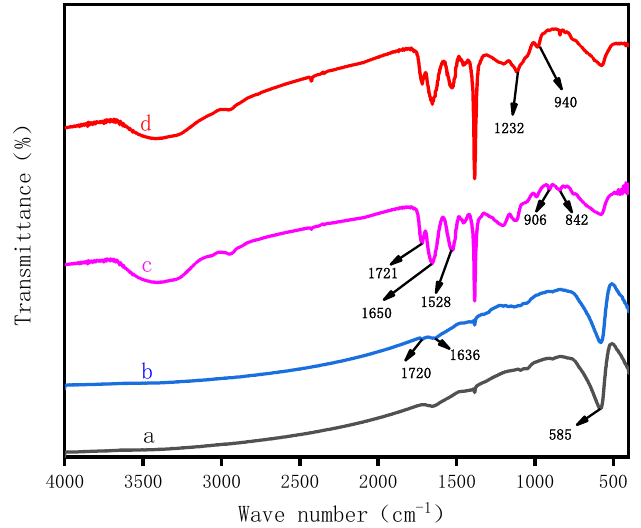
Figure 2. Infrared spectra of ( a ) Fe 3 O 4 ; ( b ) activated Fe 3 O 4 ; ( c ) Fe 3 O 4 /P (GMA-MBA) and ( d ) Fe 3 O 4 /P (GMA-MBA)-PO 4 .